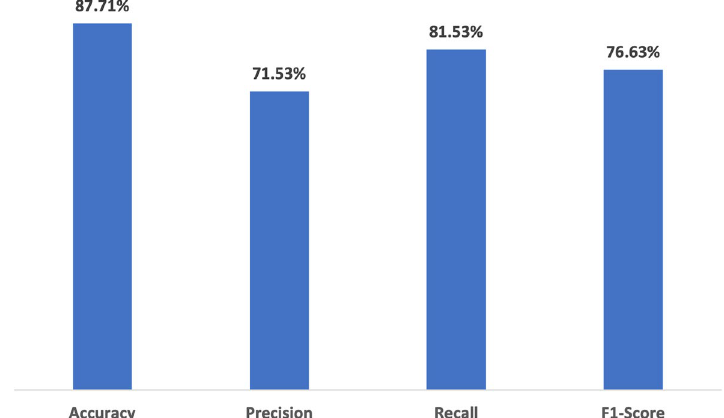
Fig. 11 The ENSEMBLE results for detecting replay attacks